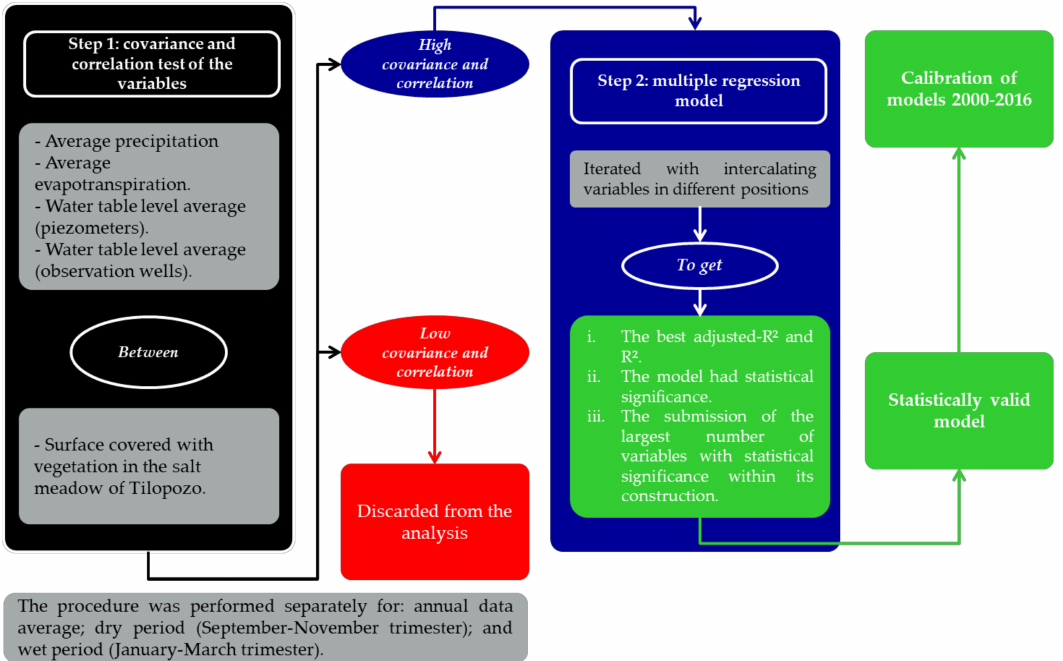
Figure 4. Two-step procedure for the selection of valid variables for the construction of multiple regression models, such as predictors of surface covered with vegetation in the salt meadows of Tilopozo, for annual, dry season and wet season